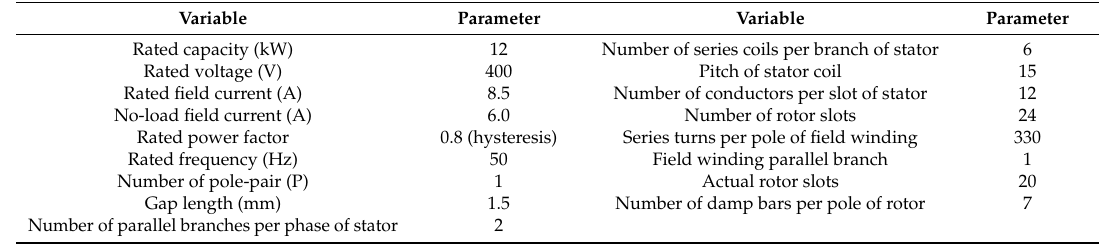
Table 1. Parameters of A1552 non-salient pole model machine. Figure 5. Experimental wiring diagram.